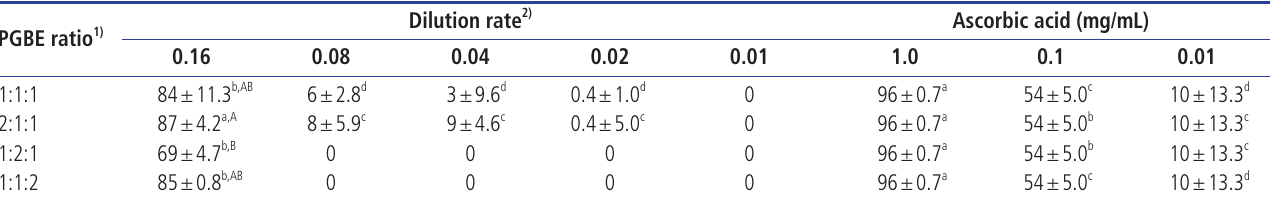
Table 2. ABTS cation radical scavenging activity of PGBE